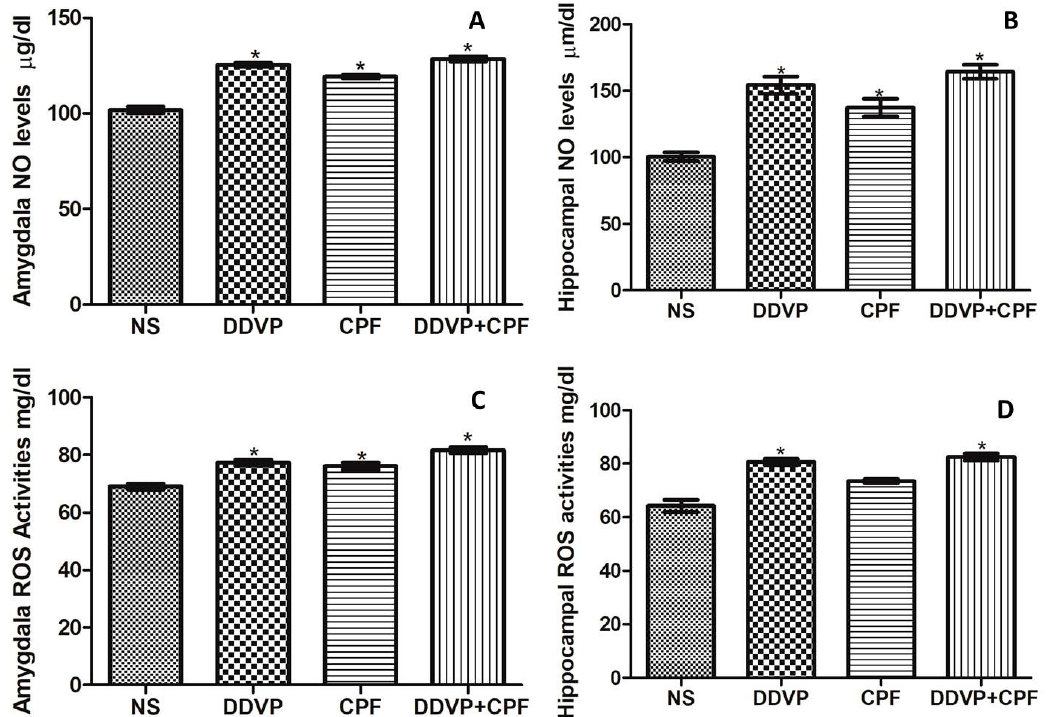
Figure 5. The effects of oral exposures to normal saline (NS), dichlorvos (DDVP) or/and chlorpyrifos (CPF) on: nitric oxide (NO) levels ( A : amydala and B : hippocampus); and reactive oxygen specieies (ROS) levels ( C : amygdala and D : hippocampus) in the exposed rats. Single asterisk (*) indicates a significant ( p ≤ 0.05) increase when compared with the NS rats. One-way analysis of variance (ANOVA) with a post hoc Bonferroni’s multiple comparison test.